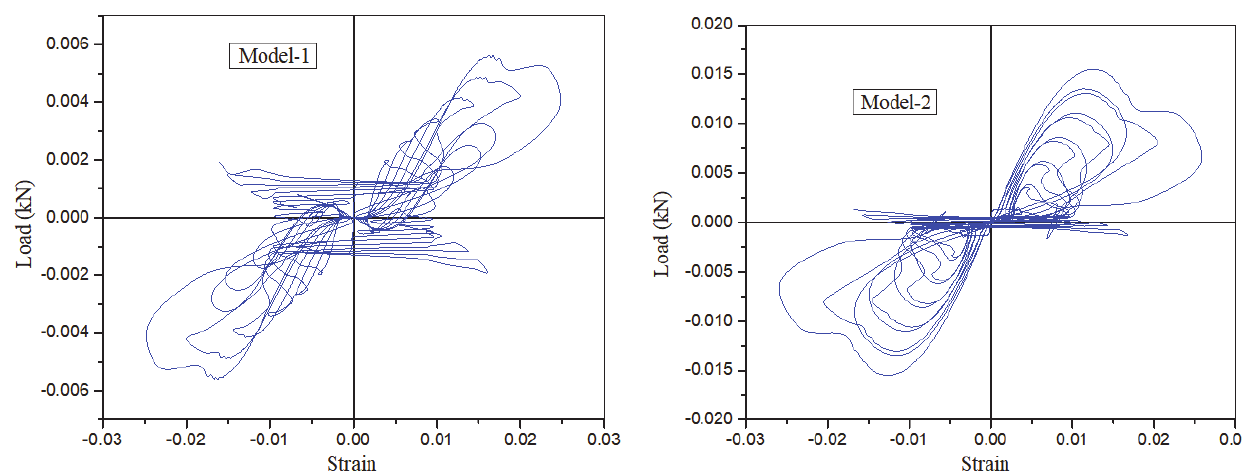
Figure 10: Load Vs strain on timber beam with 1.8 (m) length,